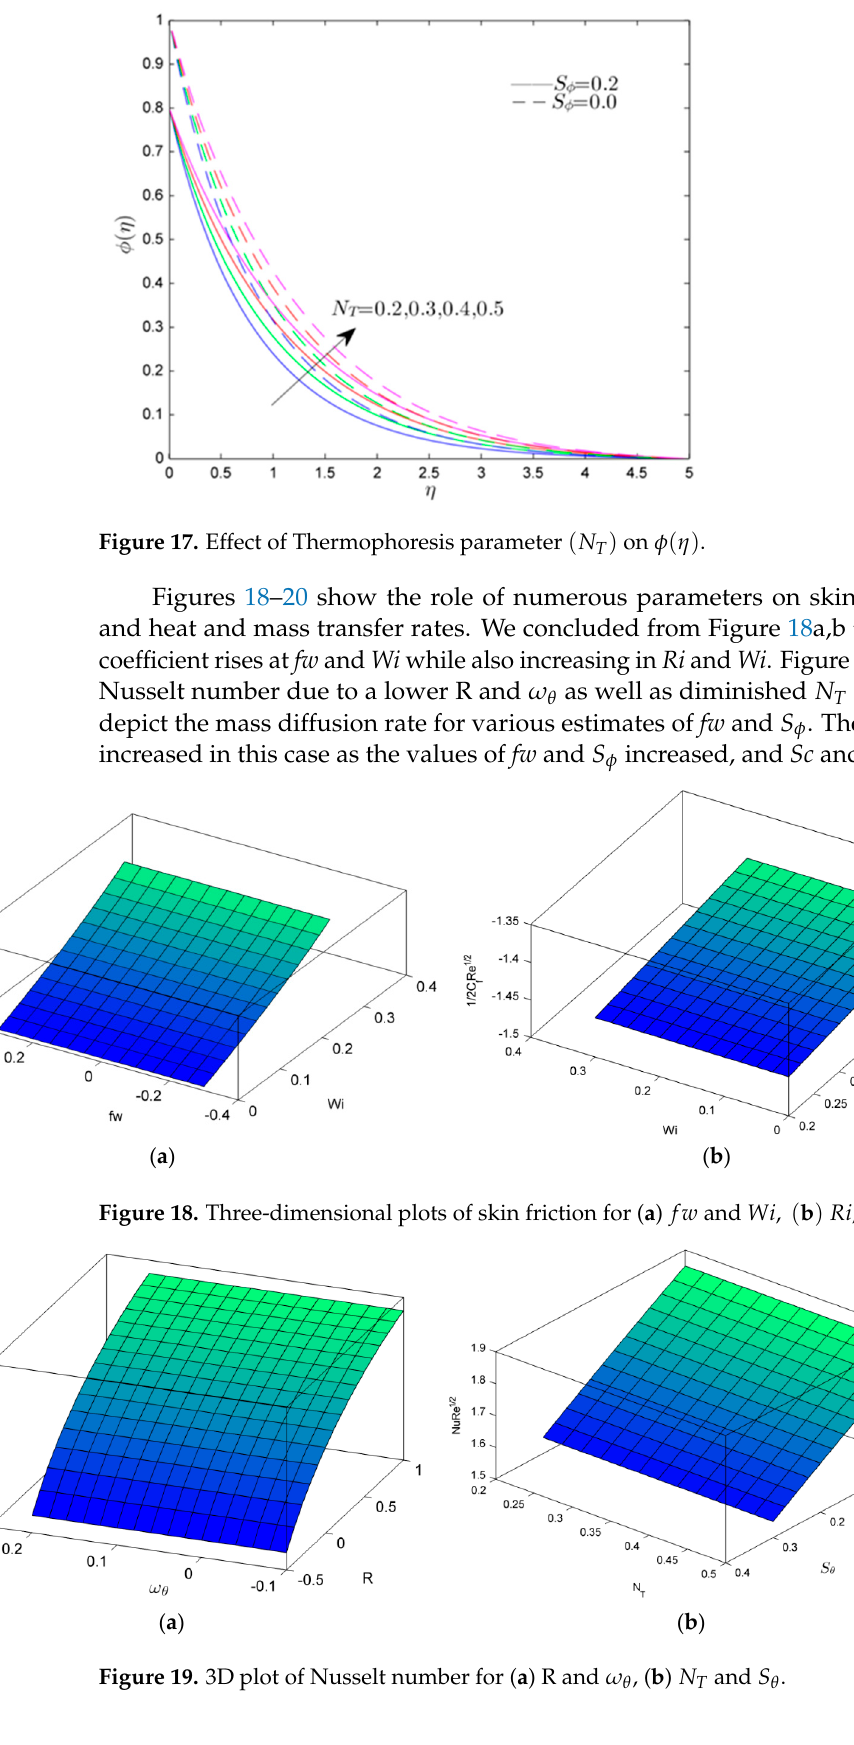
Figure 16. Effect of Schmidt number (𝑆𝑐) on 𝜙(𝜂) .